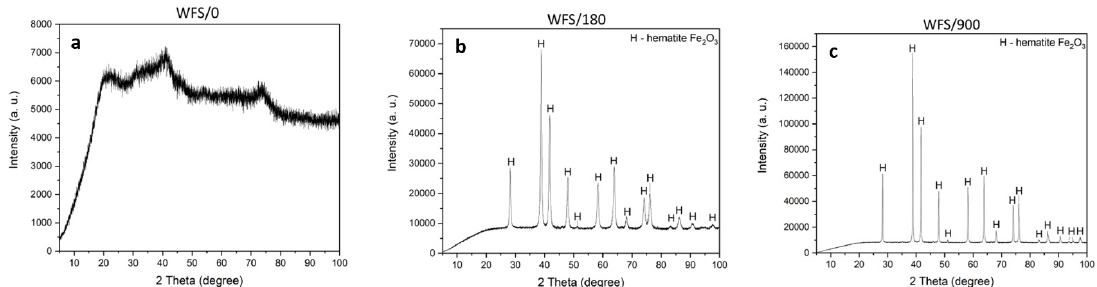
Figure 8. XRD pattern of ( a ) WFS/0 samples (non-calcined Fe waste sludge); ( b ) WFS/180 (waste Fe sludge calcined at 180 °C); and ( c ) WFS/900 (waste Fe sludge calcined at 900 °C).